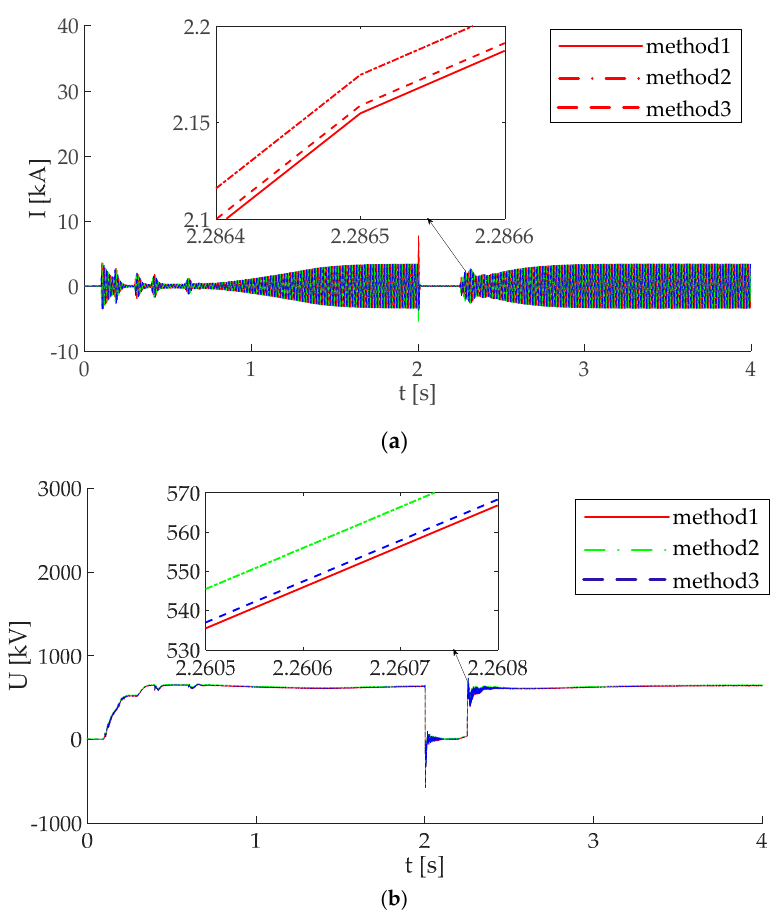
Figure 9. The ground fault in DC line. ( a ) The AC current. ( b ) The DC voltage.